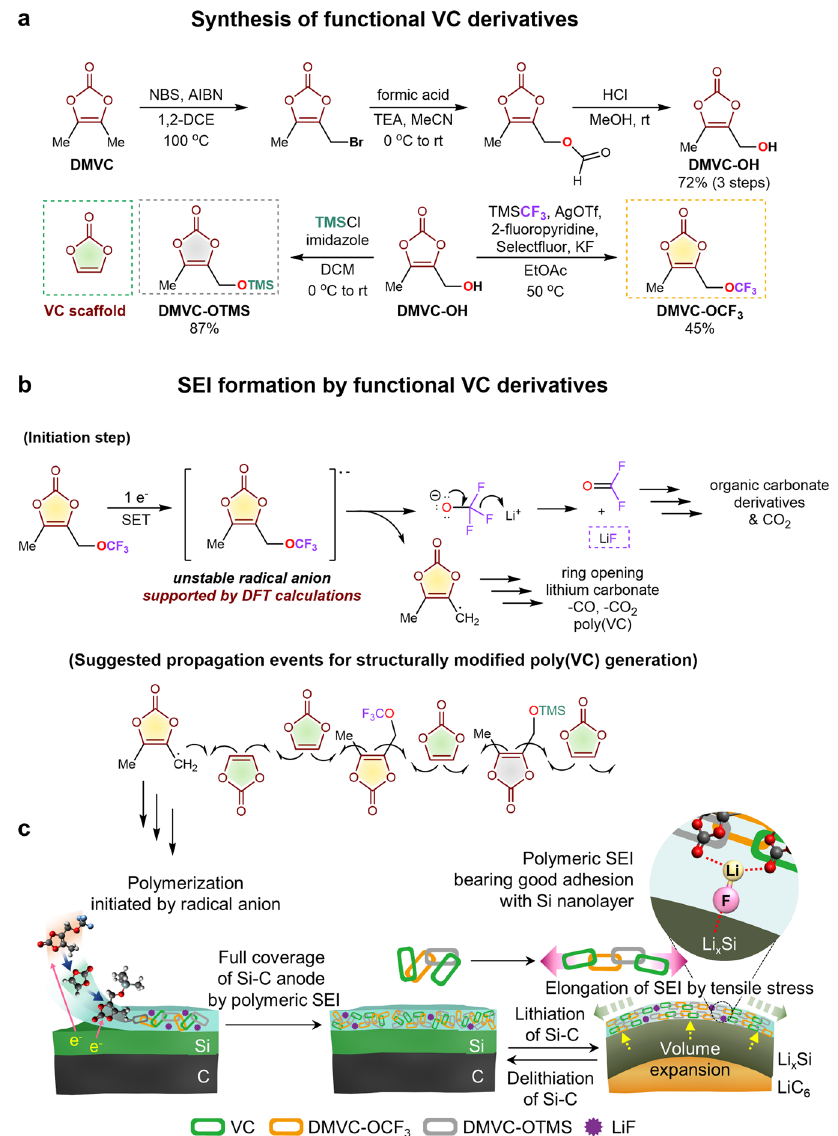
Fig. 1 Synthesis of functional VC derivatives and transformation of additives to form SEI on the Si – C anode. a Synthesis of DMVC-OTMS and DMVC- OCF 3 . b Electrochemical transformations of DMVC derivatives. SET single electron transfer, NBS N -bromosuccinimide, AIBN azobisisobutyronitrile, 1,2- DCE 1,2-dichloroethane, TEA trimethylamine, MeCN acetonitrile; EtOAc ethyl acetate. c Design of a deformable and stable SEI using VC, DMVC-OCF 3 and DMVC-OTMS on the Si – C